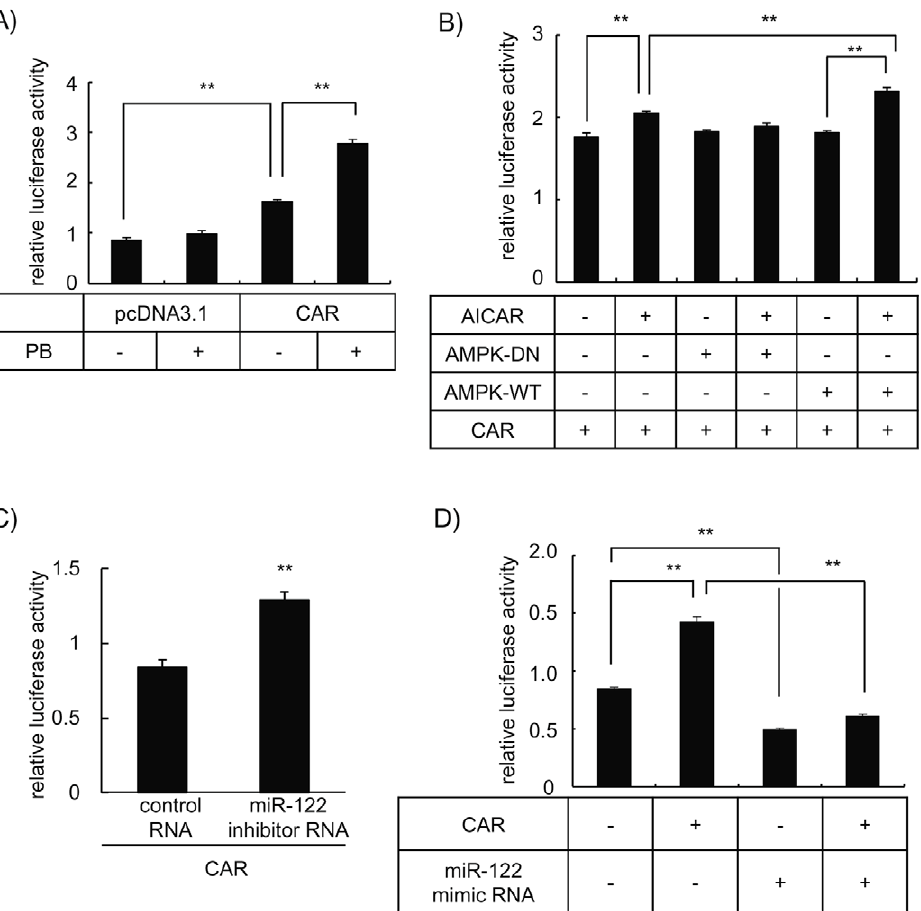
Figure 5. The inhibitor or mimic RNA for miR-122 induces activation or suppression, respectively, of CAR-mediated PBREM transactivation in HepG2 cells. A , Cells seeded in 24-well multi-dish were transfected either with CAR/pcDNA3.1 or empty pcDNA3.1 (0.2 m g) in conjunction with the PBREM/pGL3-120 (0.7 m g) and pRL-TK vector (0.1 m g). Cells were treated with PB (1 mM) 12 h after transfection. The luciferase activity was determined 48 h after PB treatment. Data were normalized with the respective Renilla luciferase activity (n=3). *, p , 0.01. B , Cells were transfected either with AMPK a 2 D C T172A/pcDNA3.1 (AMPK-DN), AMPK a 2/pcDNA3.1 (AMPK-WT) or empty pcDNA3.1 (0.7 m g) in conjunction with the PBREM/pGL3-120 (0.2 m g), phRL-TK (0.05 m g) and CAR/pcDNA3.1 (0.05 m g) vectors. Cells were treated with AICAR (1 mM) 12 h after transfection. The luciferase activity was determined 48 hr after AICAR treatment. Data were normalized with the respective Renilla luciferase activity (n=3). *, p , 0.01. C , Cells were transfected either with the miR-122 inhibitor or the control RNA (40 pmol) in conjunction with the PBREM/pGL3-120 (0.12 m g), pRL-TK (0.04 m g) and CAR/pcDNA3.1 (0.04 m g) vectors. The luciferase activity was determined 48 hr after transfection. Data were normalized with the respective Renilla luciferase activity. (n=3). *, p , 0.05. D , Cells were transfected with the miR-122 mimic RNA or the control RNA (10 pmol) in conjunction with CAR/pcDNA3.1 or pcDNA3.1 vector (0.04 m g) as well as the PBREM/pGL3-120 (0.12 m g) and pRL-TK vector (0.04 m g). The luciferase activity was determined 48 h after transfection. Data were normalized with the respective Renilla luciferase activity (n=3). **, p ,